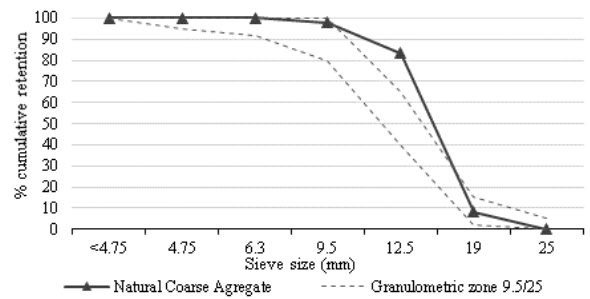
Figure 2. Granulometric curve of the natural coarse basaltic aggregate.